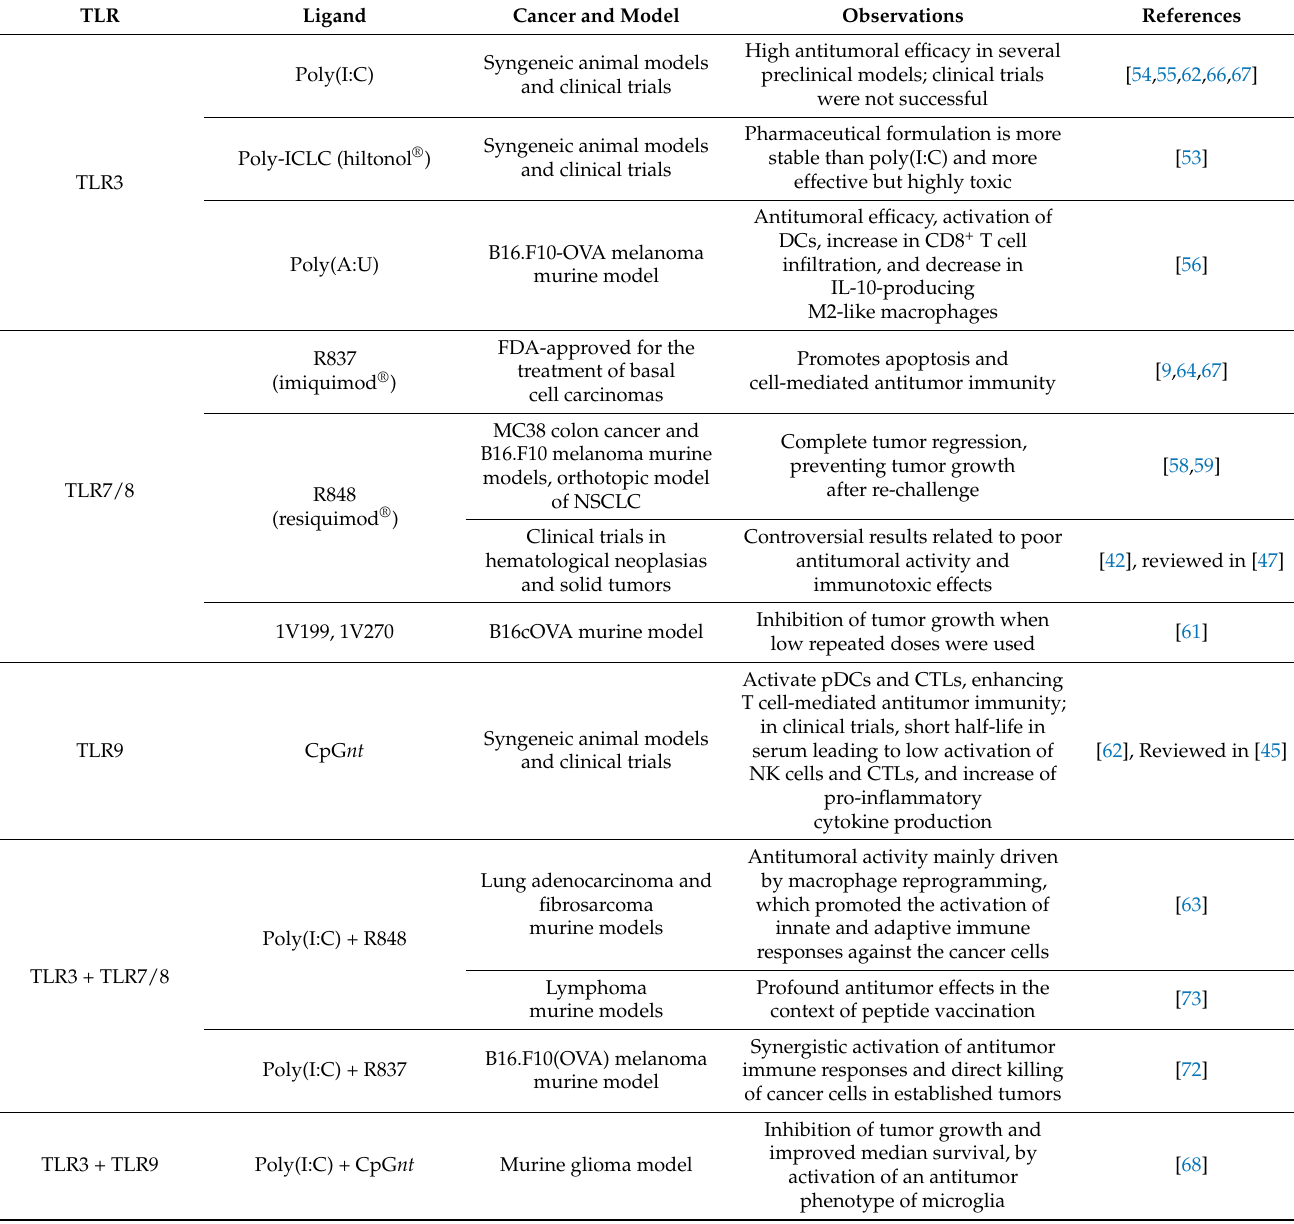
Table 1. Main endosomal TLR agonists, biological and antitumor effects, and examples of combina- tions of TLR-TLR ag and TLR-STING ag